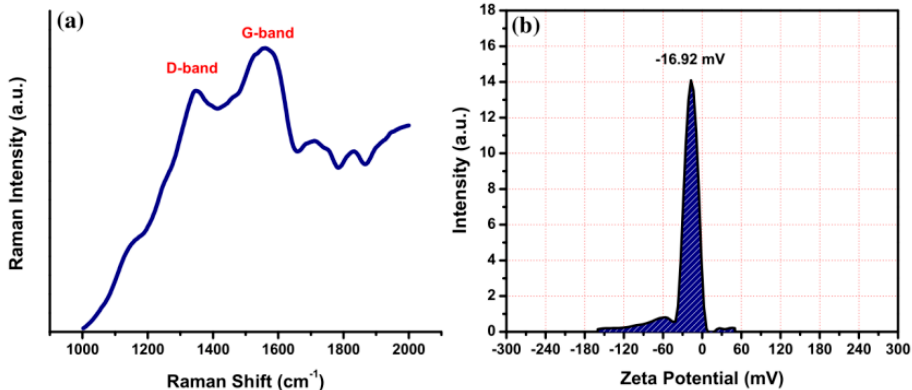
Figure 3. ( a ) Raman spectrum and ( b ) zeta potential value of VV-CDs.